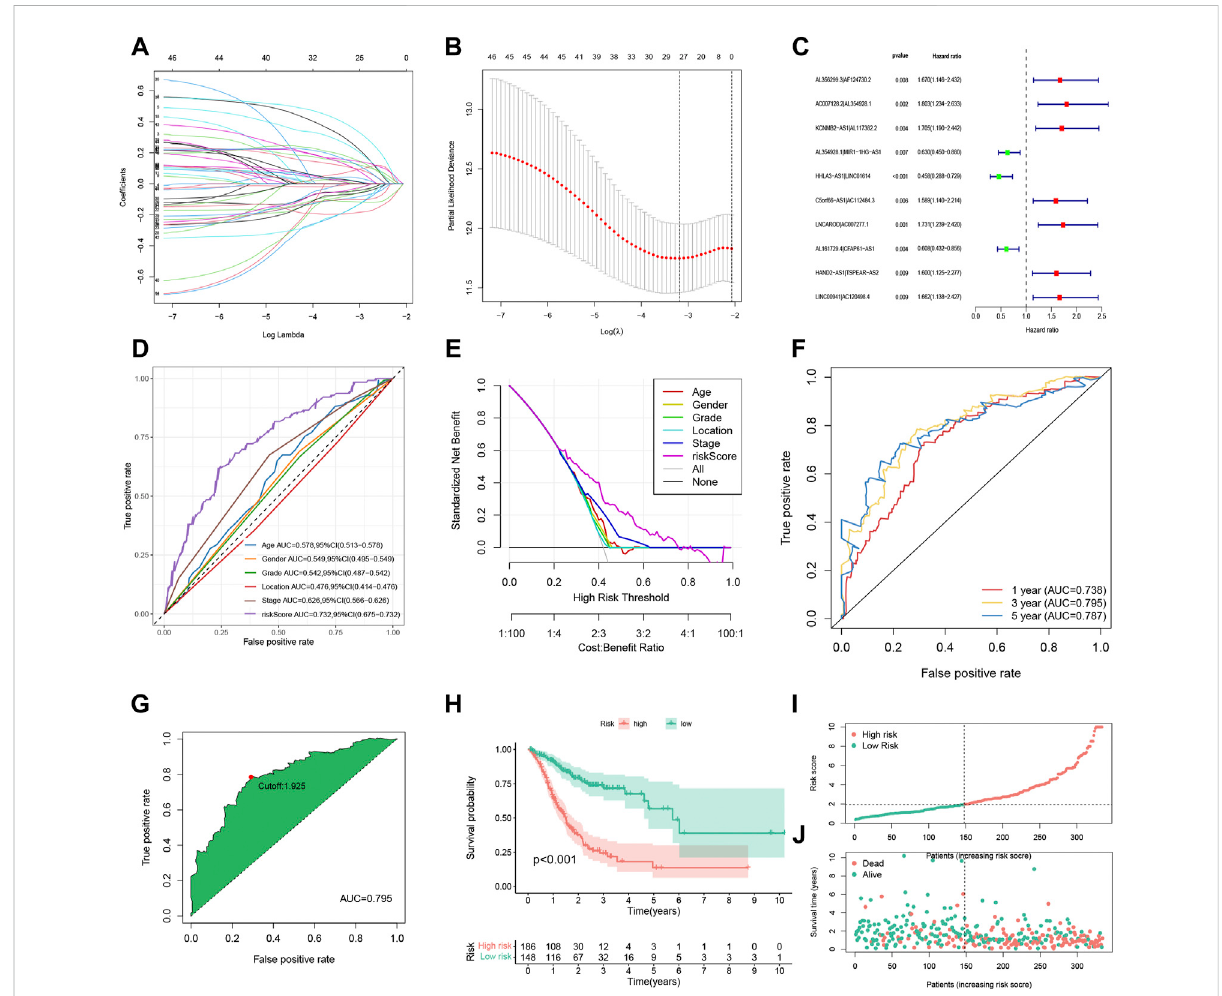
FIGURE 2 Construction and evaluation of the FRLP risk score model in TCGA cohort. (A) Least absolute shrinkage and selection operator (LASSO) coef fi cients of 27 prognosis-related FRLPs. (B) Tenfold cross-validation for tuning parameter selection in the LASSO model. (C) Forest plot showing 10 FRLPs identi fi ed by multivariate Cox regression analysis. (D) Receiver operating curve (ROC) comparing the risk score and other clinical factors in predicting total OS. (E) Decision curve analysis (DCA) curves estimating the predictive ef fi cacy of the risk score from the perspective of clinical bene fi t. The y -axis refers to the net bene fi t. The x -axis refers to the predicted OS. The black line represents the hypothesis that all patients survive in 5 years. Thegrayline representsthehypothesisthat nopatients stayaliveformore than1 year. (F) ROC curveforpredicting1-,3-, and5-year overall survival (OS) of the FRLP risk score model. (G) Cut-off point of the risk score model. (H) Kaplan – Meier plot of high- and low-risk patients. (I) The risk score distribution. Green dots represent risk scores for low-risk patients; red dots represent risk scores for high-risk patients. (J) The relationship between survival status and risk score. The horizontal ordinate represents the number of patients; the vertical ordinate represents risk score (AUC, area under curve; CI, con fi dence